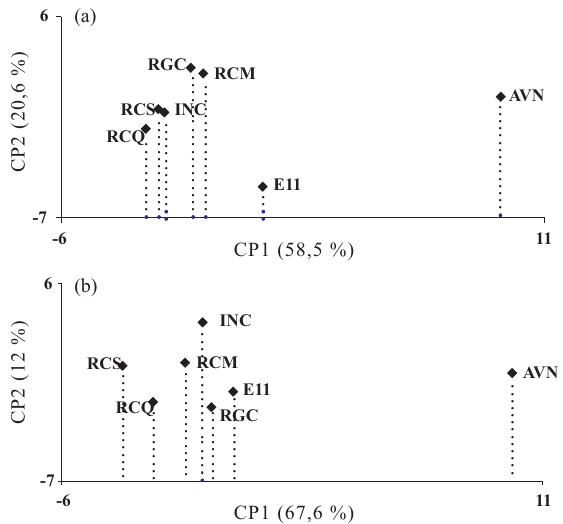
Figura 1. Dispersão dos escores das áreas estudadas em relação aos dois primeiros CPs, tendo como base as variáveis medidas a partir de amostras de solo das camadas de 0 a 5 cm (a) e 5 a 20 cm (b) de profundidade. AVN: área de vegetação natural de mata secundária, E11: área onde não foi realizado o corte das árvores do primeiro ciclo (eucalipto com 11 anos), RCM: reforma sem a remoção de resíduos (cultivo mínimo), RGC: reforma com remoção dos restos culturais (galhos e cascas), RCS: reforma com remoção dos restos culturais e da serapilheira, INC: reforma com incorporação de todos os resíduos com grade e RCQ: reforma com a queima de todos os